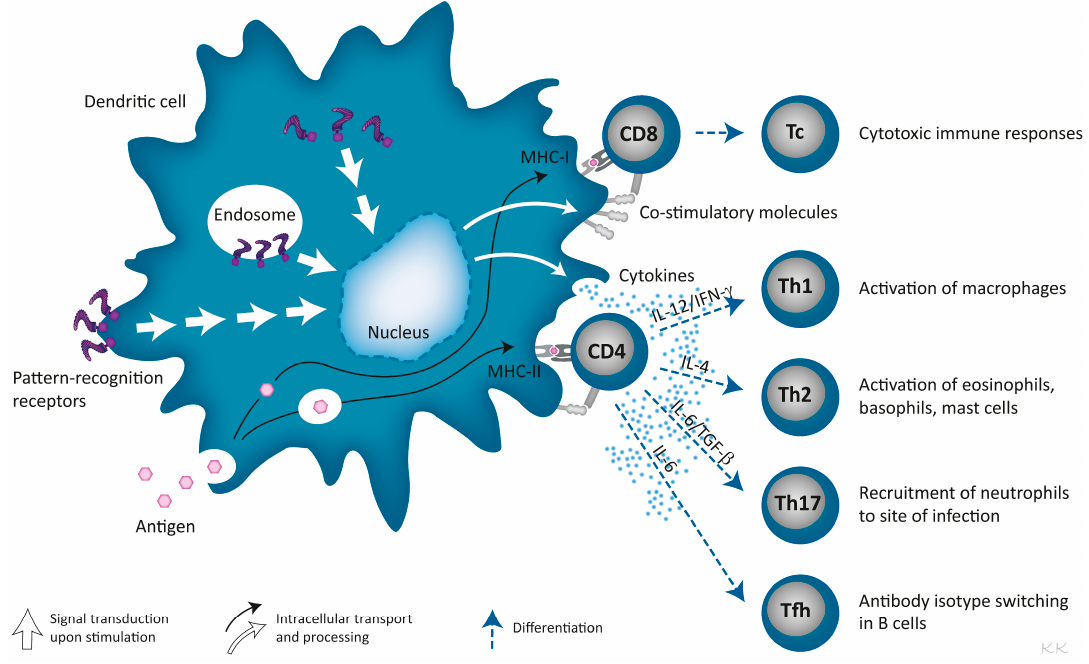
Figure 2. Major immunological responses derived by the activation of DCs through PRRs, situated on the cell surface, in the cytosol or in the endosomes. The antigen is phagocytosed, processed and presented on MHC-I via cross-presentation or on MHC-II to antigen-specific CD8 + and CD4 + T cells, respectively. Activation of the DC upregulates co-stimulatory molecules and secretion of cytokines that provide activation signals to the antigen-specific T cells. Activation of CD8 + T cells may require additional IL-2 from CD4 + T cells (not shown) to become cytotoxic T cells. Activated CD4 + T cells differentiate to distinct effector populations depending on the received cytokine signals; Th1 requires secretion of IL-12/IFN- γ ; Th2 requires IL-4; Th17 requires IL6/TGF- β ; and follicular T-helper cells (Tfh) requires IL-6.